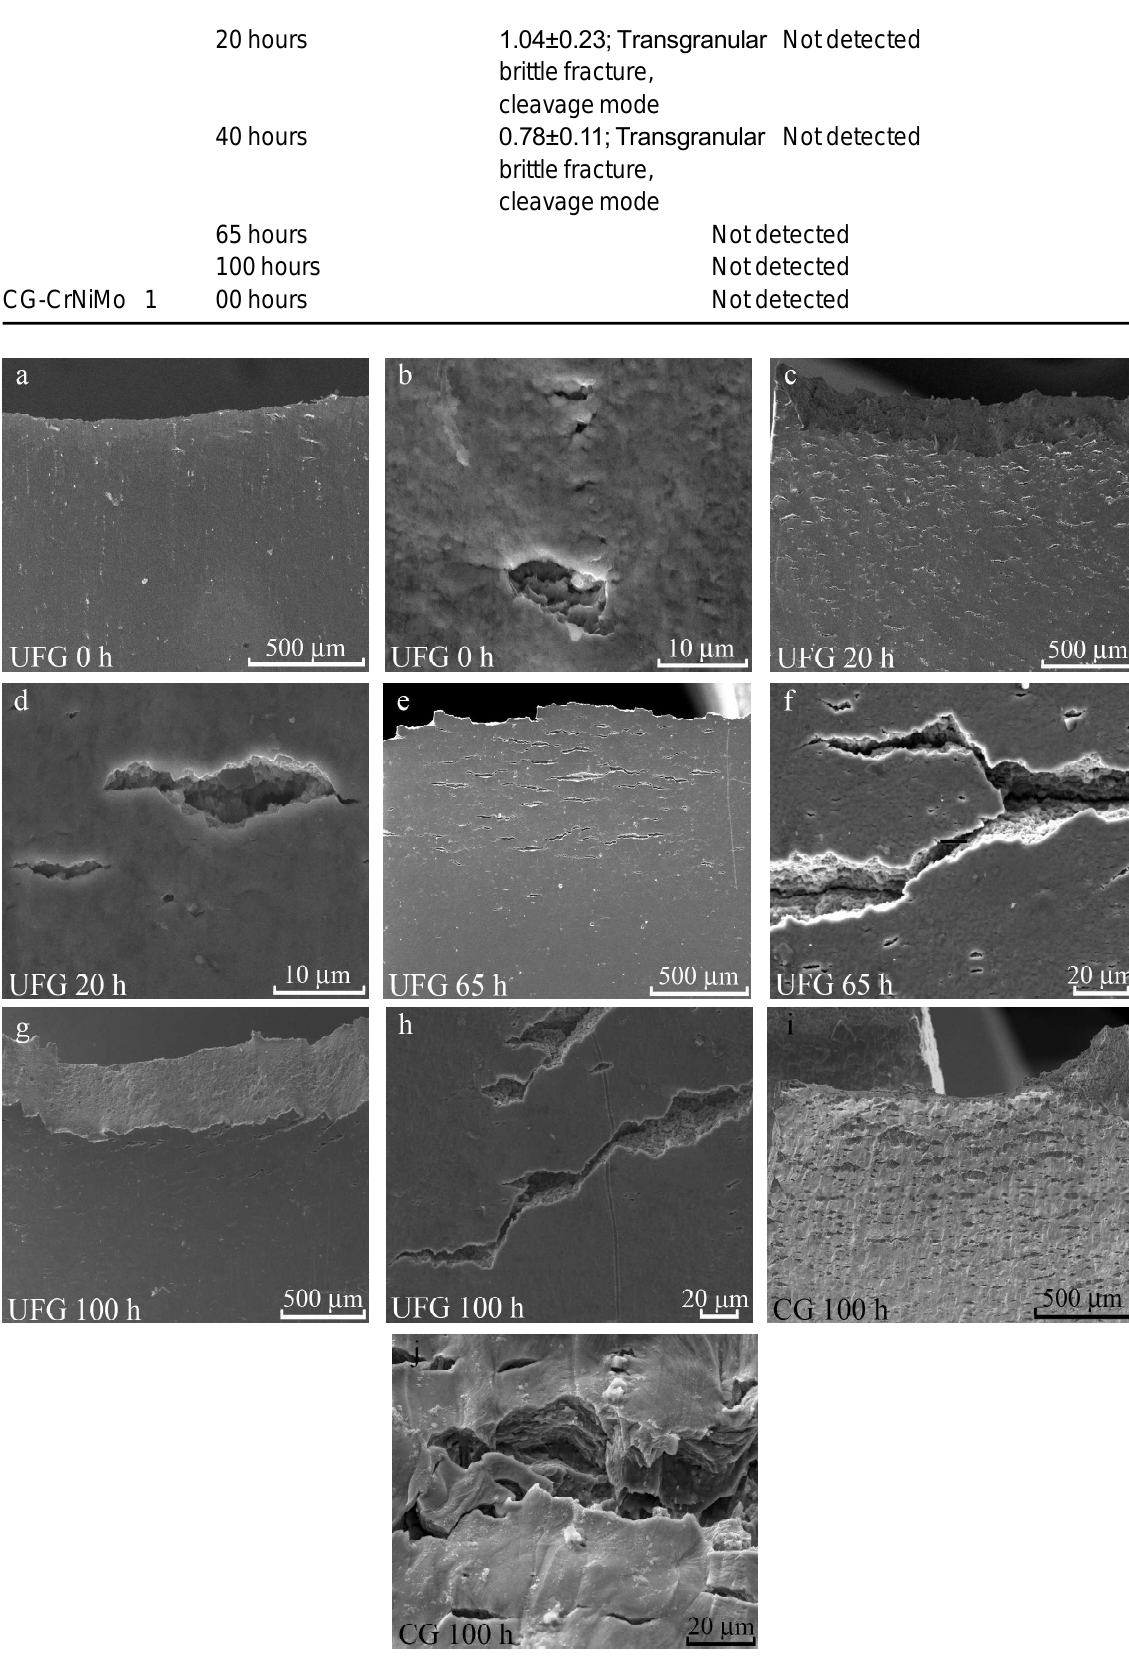
Fig. 15. SEM micrographs of the side-surfaces of the UFGCrNiTi (a-h) and CG-CrNiTi (i, j) steel specimens depending on hydrogen-charging duration: a, b – hydrogen-free, c, d – hydrogen-charged for 20 hours, e, f – hydrogen-charged for 65 hours, g-j – hydrogen-charged for 100 hours. Images (b, d, f, h, j) are magnified elements of the images (a, c, e, g, i) obtained near the fracture